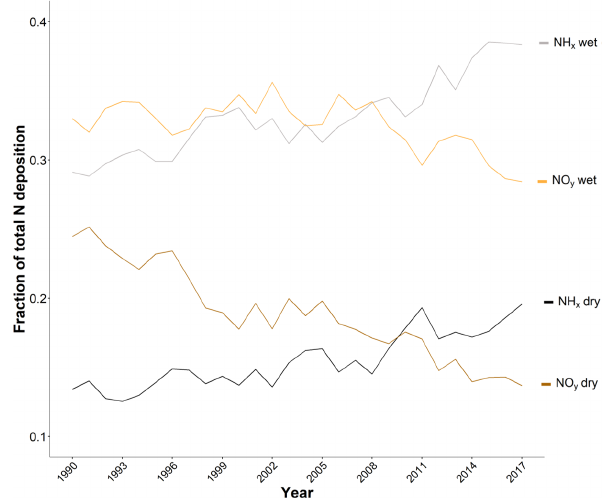
Figure 10. Fraction of the total nitrogen (N) deposition over the UK terrestrial surface for four forms of nitrogen (N) deposition, for grid average land cover, from 1990 to 2017: total wet and dry deposition of reduced N (NH x ) and wet and dry deposition of oxi- dised N (NO y